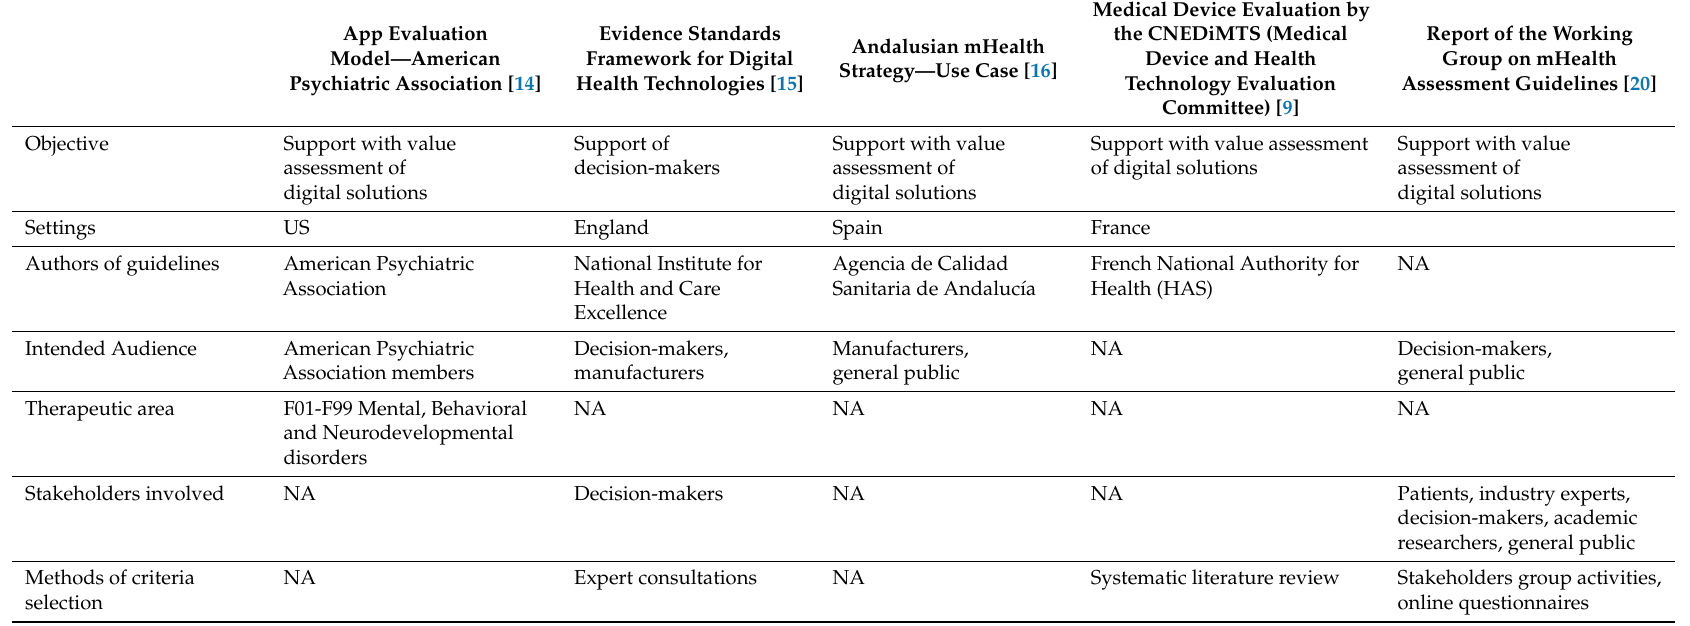
Table A2. General